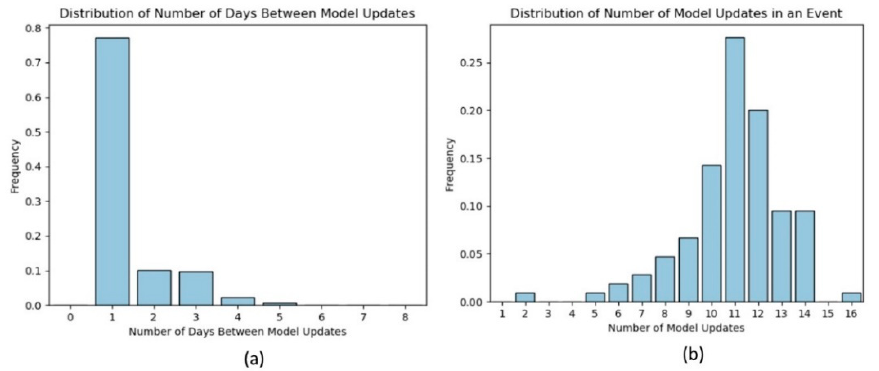
Figure 10. ( a ) The number of days between updates to the SSM model. ( b ) The number of SSM model updates within an event. Both figures represent the frequency for which the model is im- proved throughout an